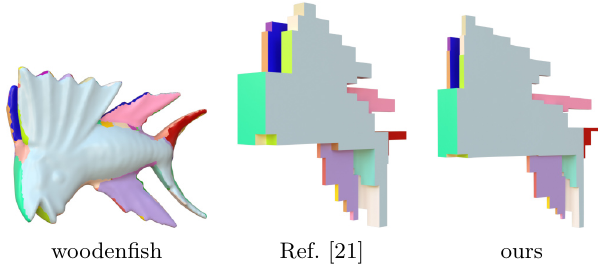
Fig. 14 Models of high genus and their polycube